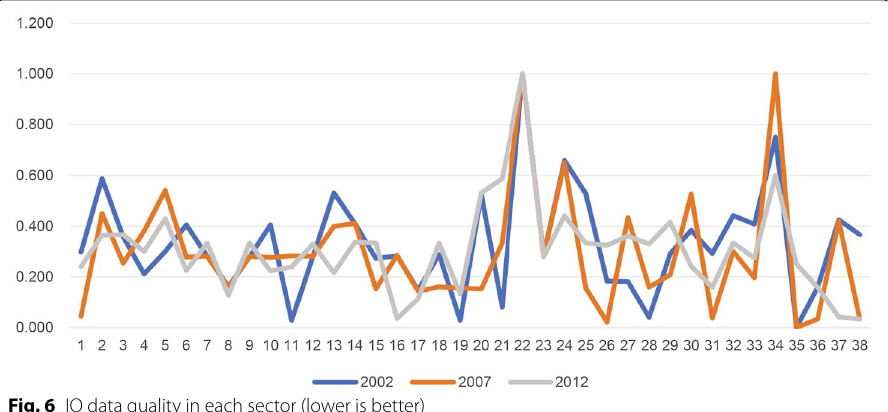
Fig. 6 IO data quality in each sector (lower is